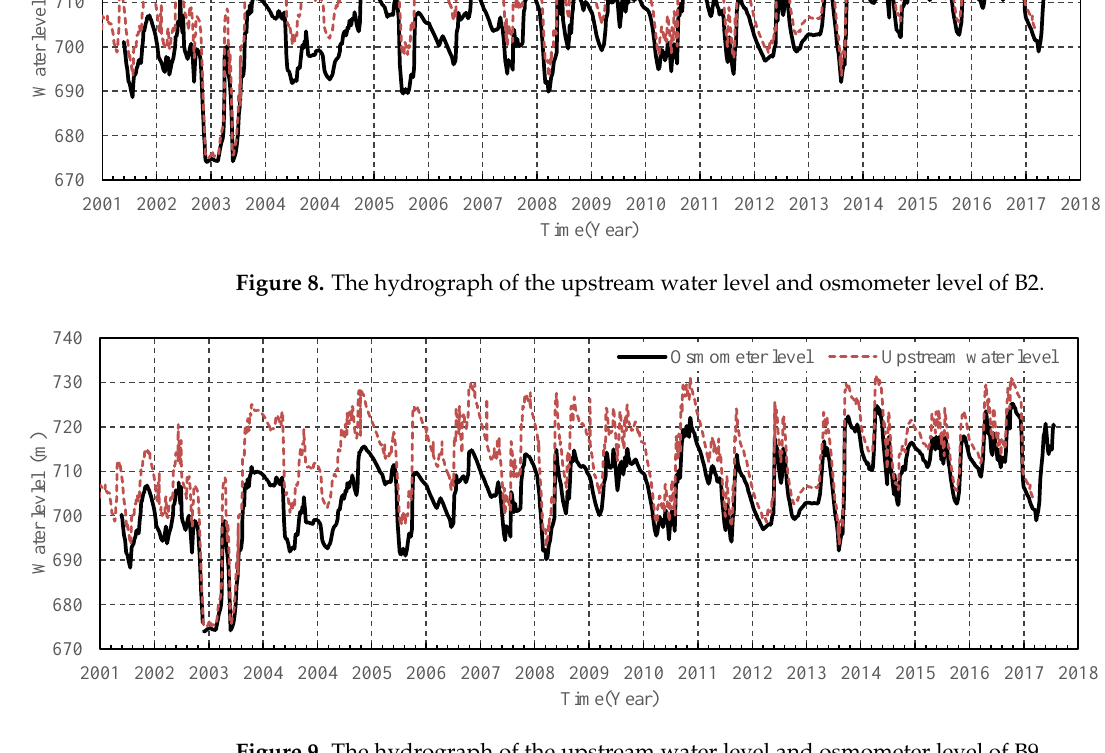
Figure 9. The hydrograph of the upstream water level and osmometer level of B9. Table 4. Osmometer levels of B2, B9 and B3 under high water levels in each year.